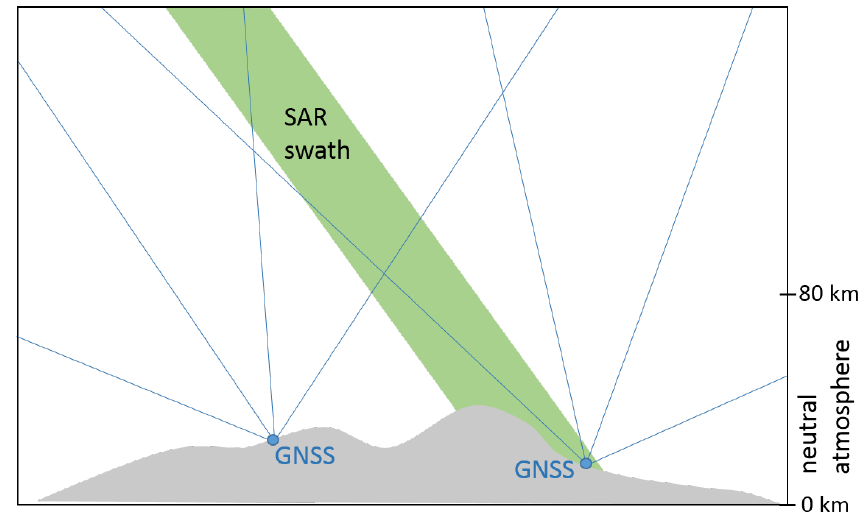
Figure 1. The geometry of SAR and GNSS propagated